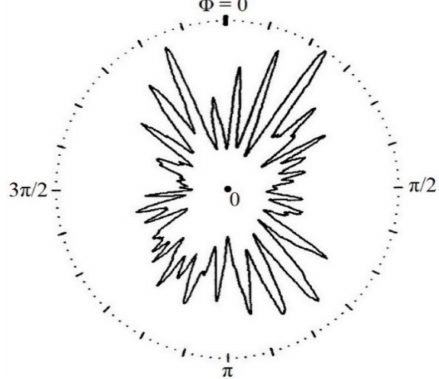
Figure 3. Front panel of the multidimensional data acquisition processor. The simplest description of cavitation comes out online after half an hour of measurement on the prototype. More compli- cated descriptions require days or weeks of recorded data analysis by a trained